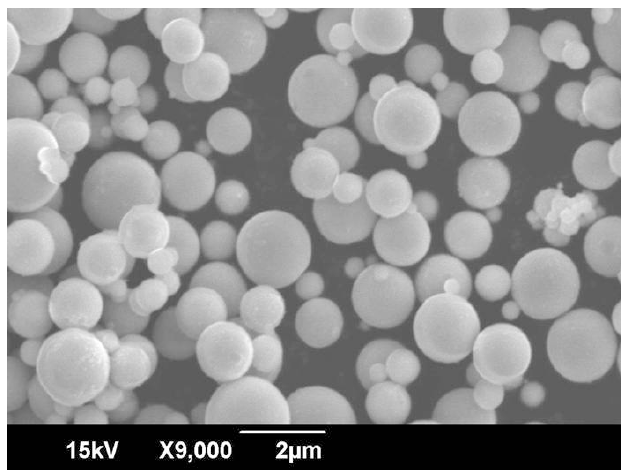
Figure 1. Scanning electron microscopy (SEM) image of the copper powder.